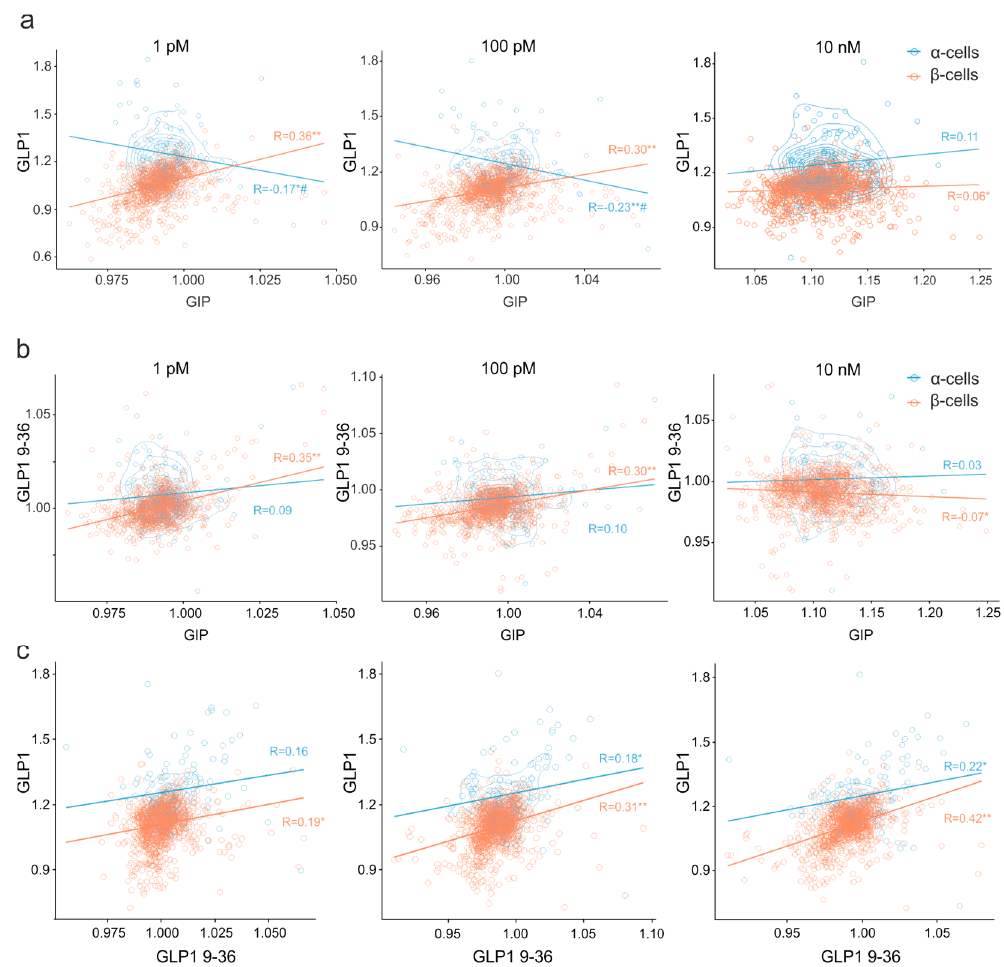
Figure 4. Dose-dependent effects on incretins on α - and β -cell populations in pancreatic islets of Langerhans. 2D scatter plots reporting the effects of incretins, GLP1 7–36 vs. GIP ( a ), GLP1 9–36 vs. GIP ( b ) and GLP1 7–36 vs. GLP-1 9–36 ( c ), added at 1 pM, 100 pM and 10 nM, on α - and β -cells, as indicated. α - and β -cells were distinguished by the positive and negative effect of adrenaline, respectively. The lines represent the least-squares fit, the Pearson’s R-values being given for α - and β -cell subpopulations, as indicated. The data is from three experiments, n = 4096 cells. Correlations are statistically significant at * p < 0.05 or ** p < 0.01.